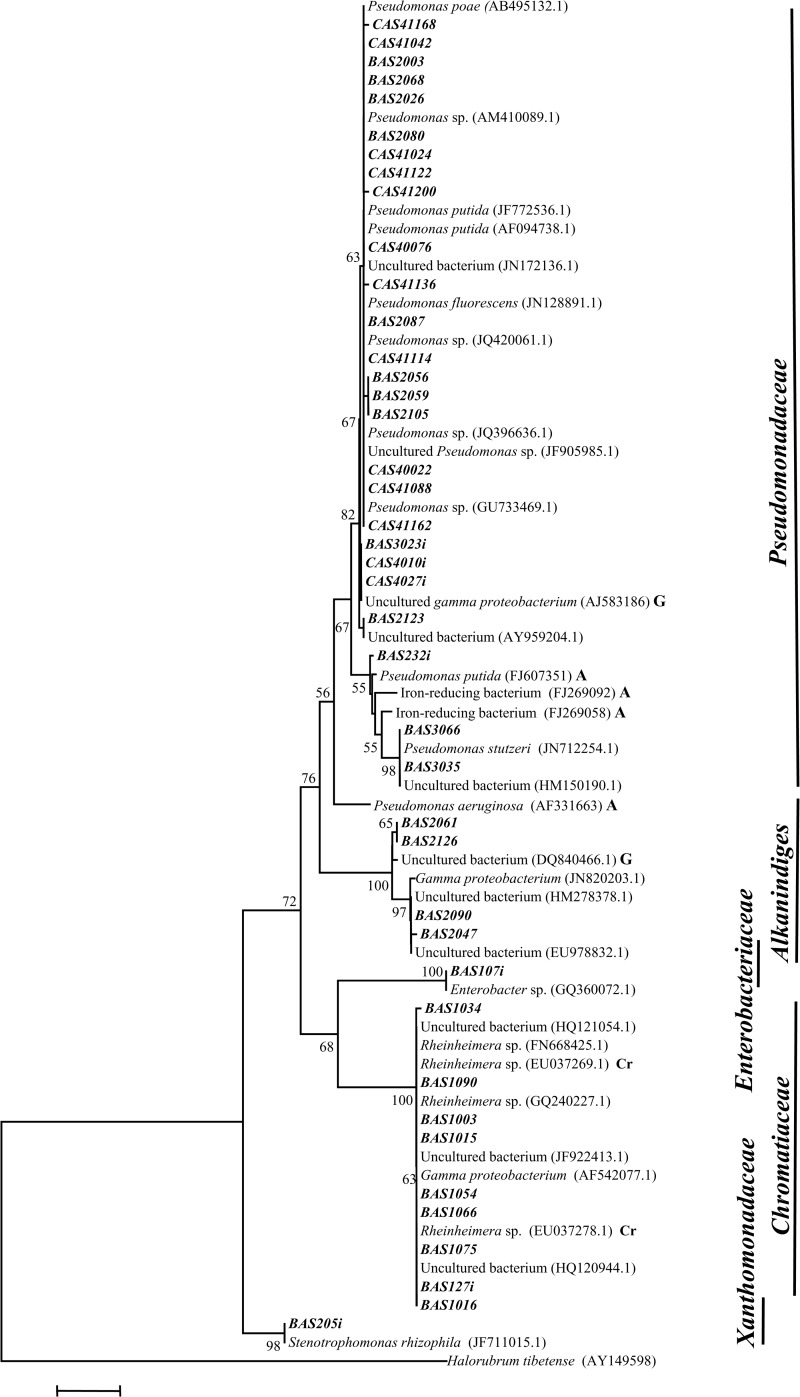
Neighbor-joining phylogenetic tree of γ-Proteobacteria.The tree is constructed based on 16S rRNA gene sequences by using Jukes-Cantor distances. 1000 bootstraps analyses are conducted and more than 50% are denoted in nodes. Sequences retrieved from As contaminated environment, groundwater and chromium contaminated sites are suffixed here as ‘A’, ‘G’, and ‘Cr’, respectively. Sequences represented in bold italic font are derived from clone libraries and bold italic font with a suffix ‘i’ are derived from isolated strains.